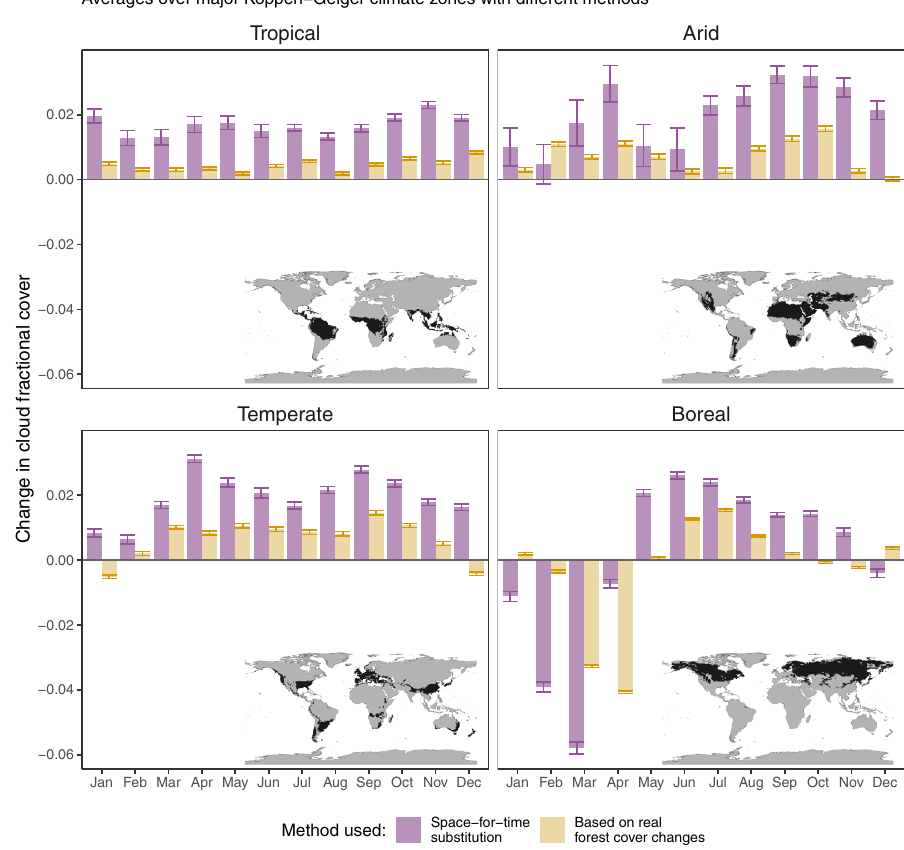
Fig. 3 Comparison between different methods to extract the change in cloud fractional cover (CFrC) following afforestation from satellite records. The seasonality of the Southern Hemisphere was shifted by 6 months to align it with that on the northern one. The error bars represent the standard error around the